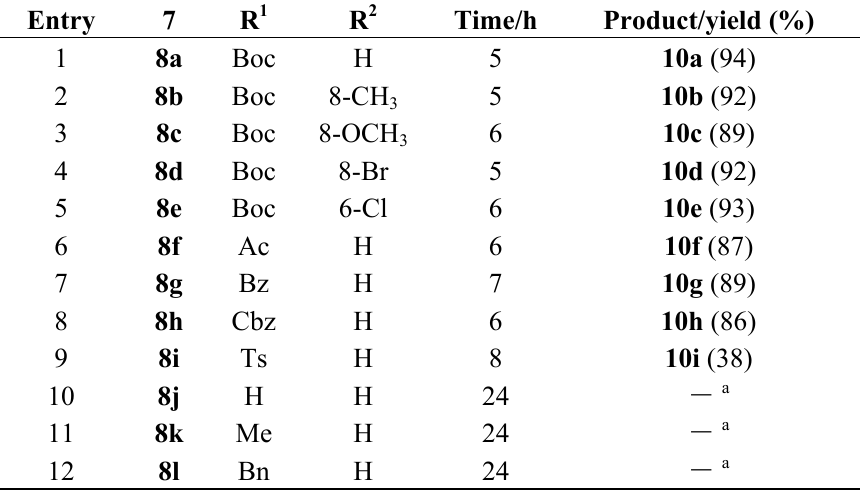
Table 2. Winterfeldt oxidation of substituted 1,2,3,4-tetrahydro- γ